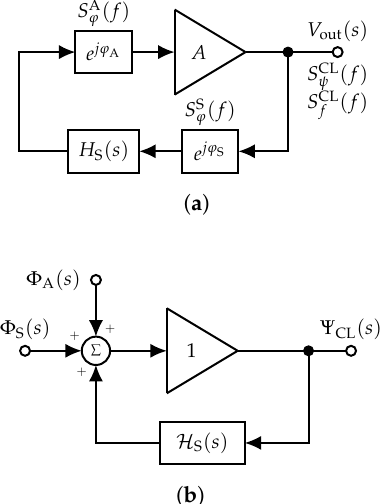
Figure 4. Basic structure of a closed-loop sensor readout system, i.e., an oscillator, together with the random phase contributions of the individual components ( a ). The use of the phase-space equivalent system ( b ) simplifies phase noise analysis as phase noise turns into additive noise, but requires the determination of the phase-space equivalent transfer function of the sensor H S ( s ) . ( a ) Closed-loop system with random phase contributions; ( b ) phase-space equivalent